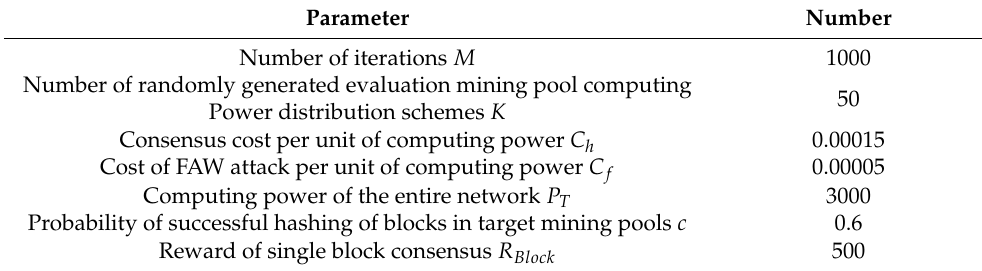
Table 1. Experimental parameter table. Parameter Number Number of randomly generated evaluation mining pool